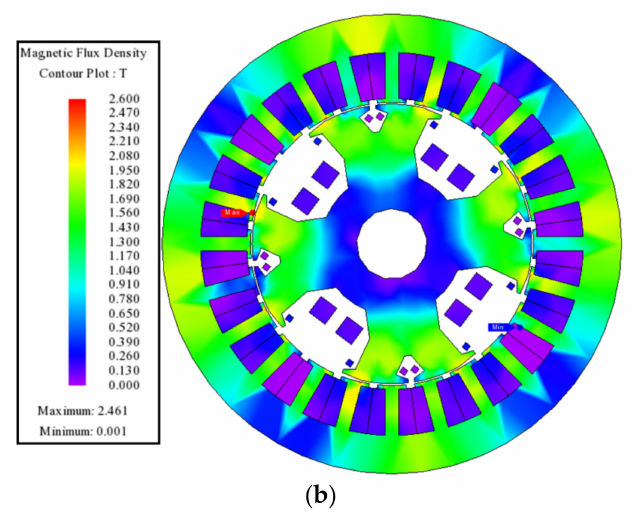
Figure 9. Magnetic flux density distribution plots for ( a ) customary, and ( b ) proposed BL-WRSM topologies based on sub-harmonic field-excitation technique.